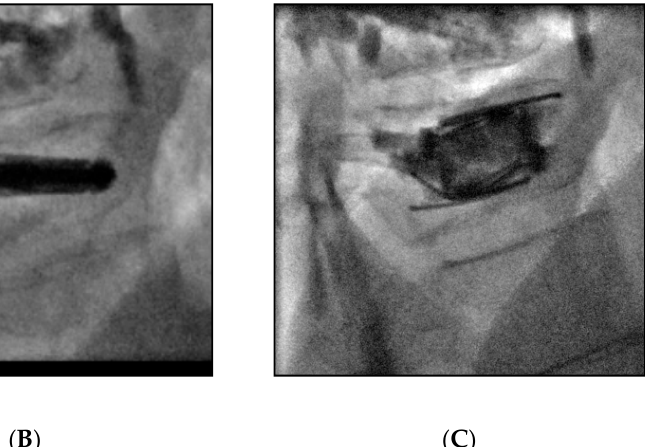
Figure 1. Spinejack ® implantation in a 49-year-old woman (Patient 18) with breast carcinoma metastasis of L2. ( A ) Sagittal reconstruction of the computed tomography, arrow. ( B ) The two devices were inserted under fluoroscopy into the vertebral body via a bilateral transpedicular approach. ( C ) After deployment and cement injection, the height of the vertebrae was restored.